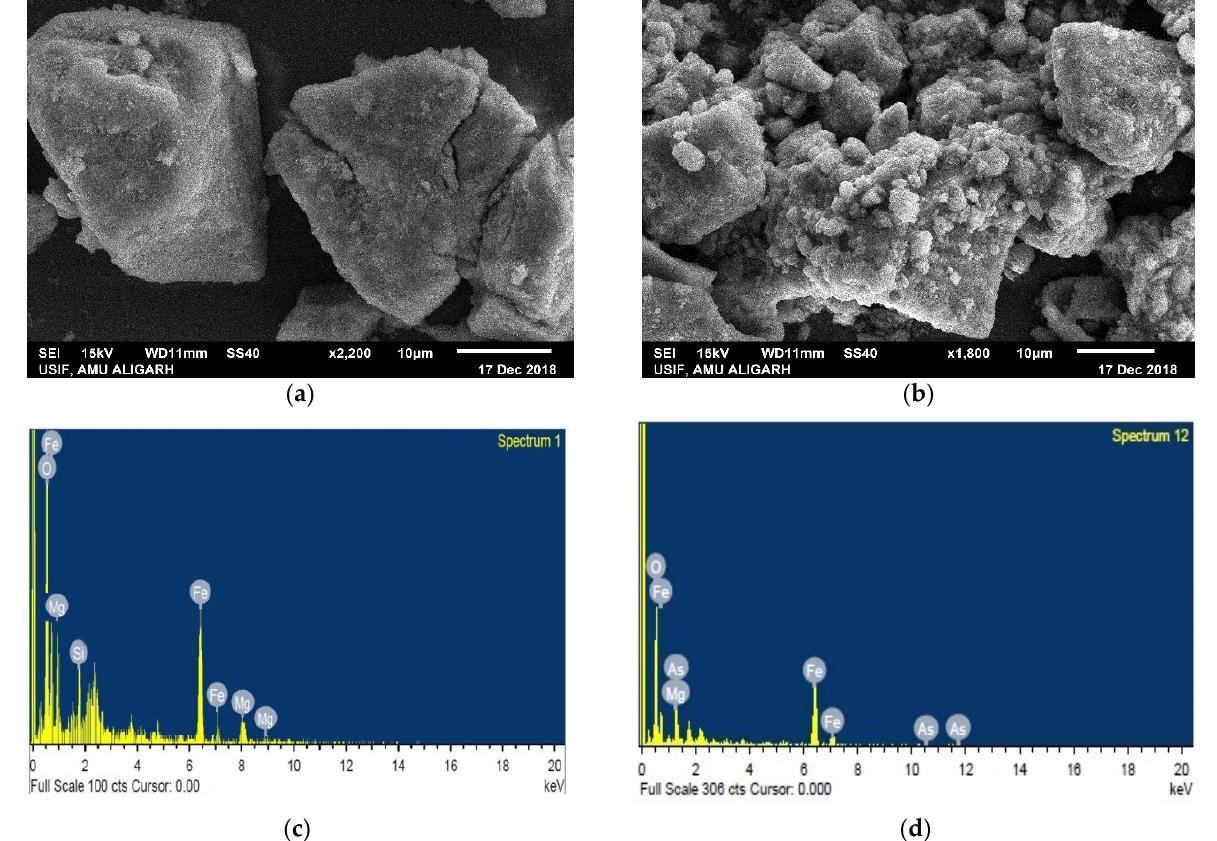
Figure 4. ( a ) Scanning electron microscopy (SEM) image of Fe (III)-Mg (II) binary oxide Np’s before adsorption, ( b ) SEM images after As (III) adsorption, ( c ) Spectrum from EDAX before adsorption of As (III), ( d ) Spectrum from EDAX showing presence of As (III) along with Fe and Mg after adsorption.